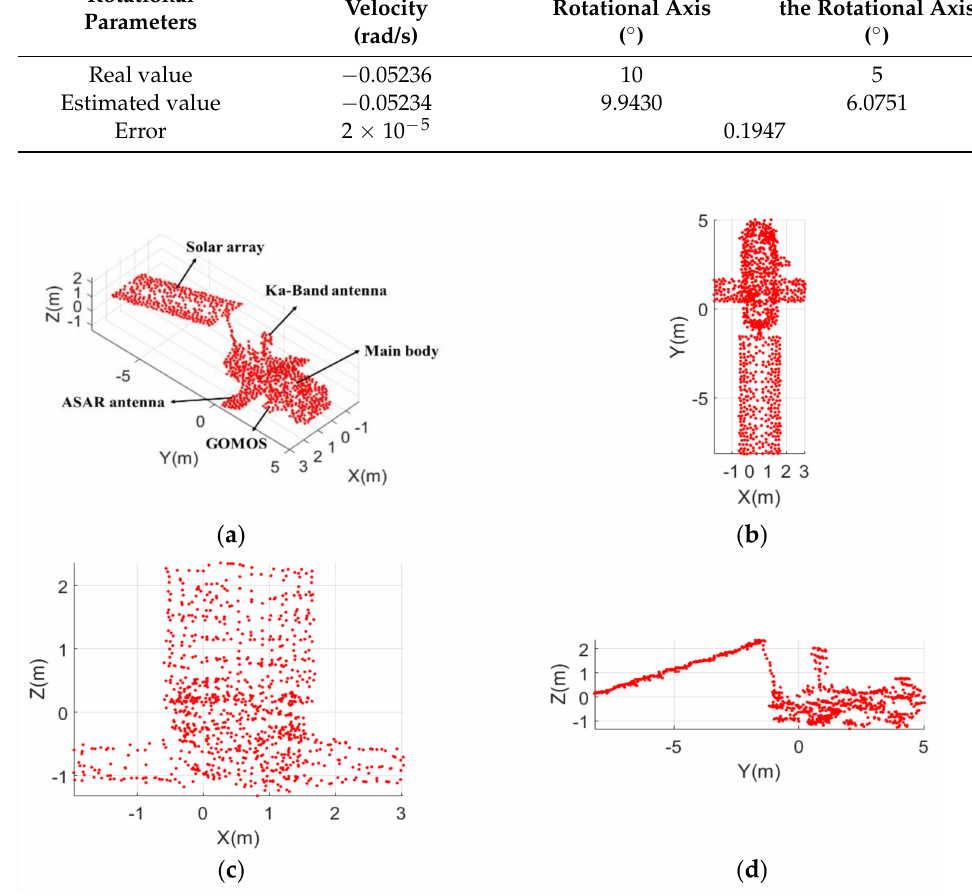
Figure 11. The reconstructed 3D point cloud of the simulated point model of ENVISAT: ( a ) The reconstructed 3D point cloud, ( b ), ( c ), and ( d ) top, side, and front